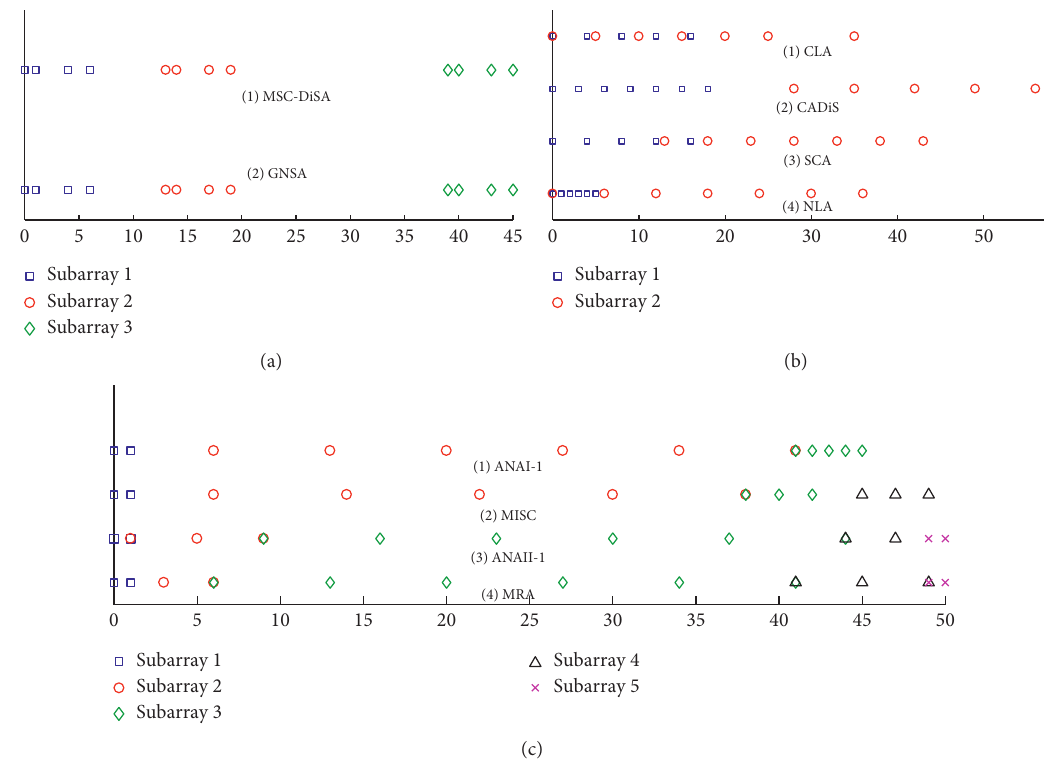
Figure 1: The structure of sparse arrays when M � 12. Table 2: Parameters of sparse arrays. Type of sparse